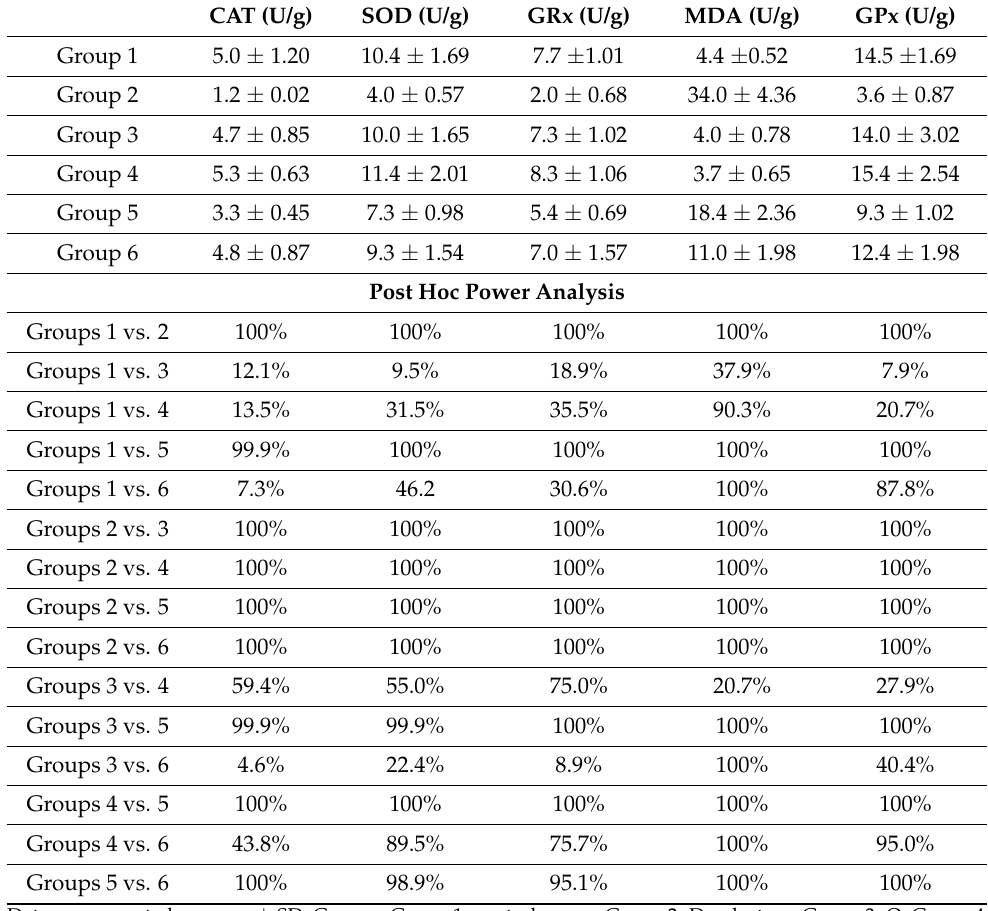
Table 3. Oxidative stress biomarkers in testicular tissue